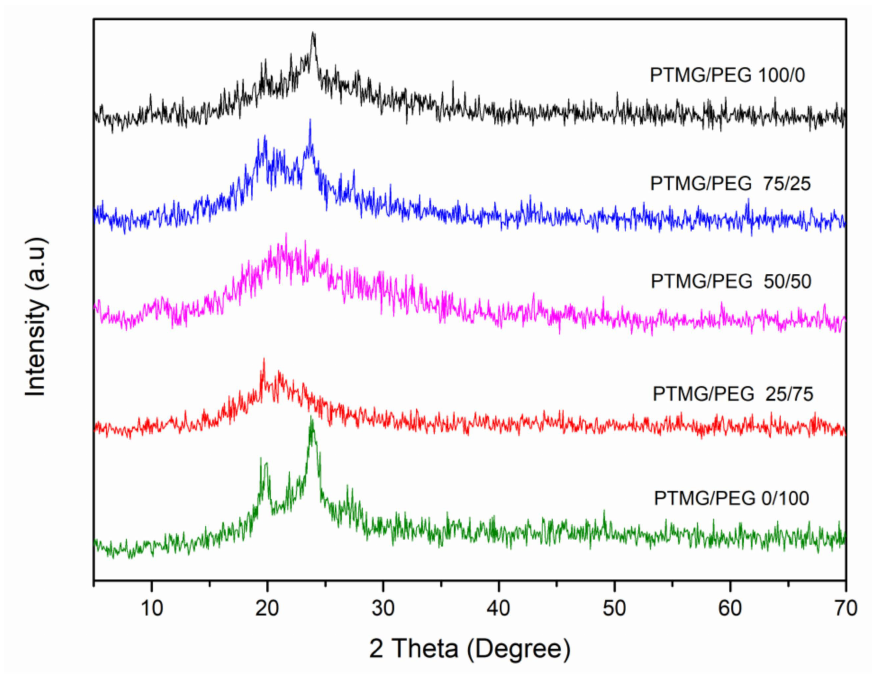
Figure 3. XRD of PTMG / PEG porous composites with di ff erent